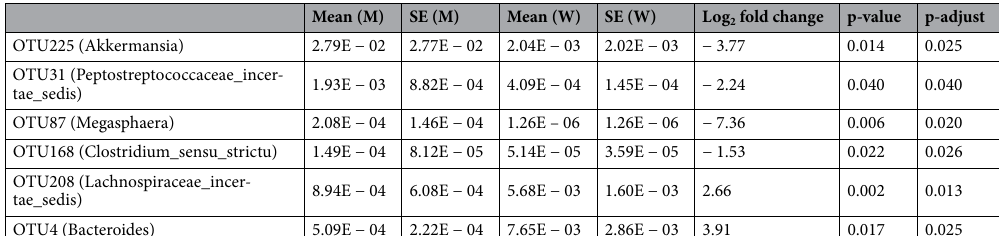
Mean (M) SE (M) Mean (W) SE (W) Log 2 fold change p-value